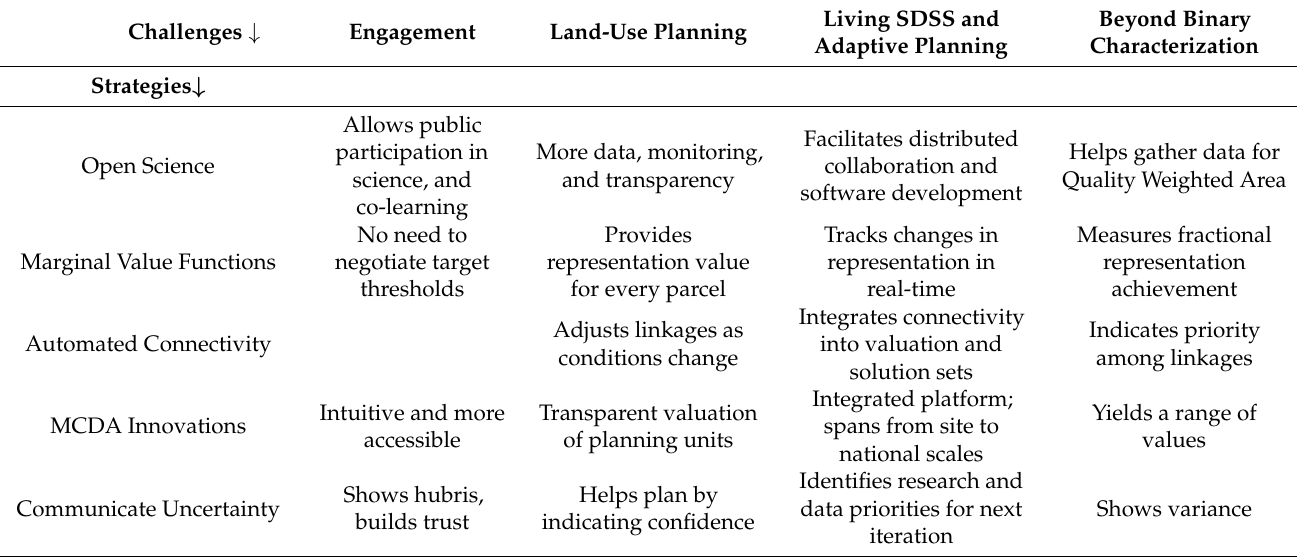
Table 1. A matrix summarizing how the strategies address the